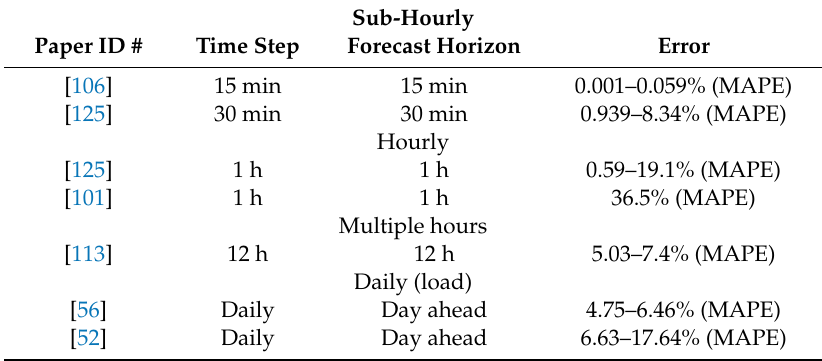
Table 2. Performance range of single step ahead forecasting models.